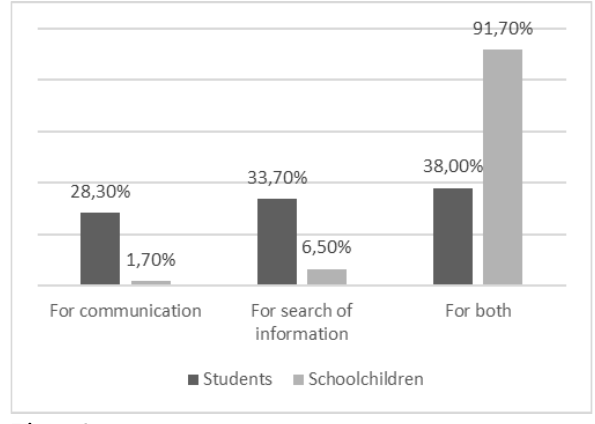
Figure 8. Purposes for using the Internet